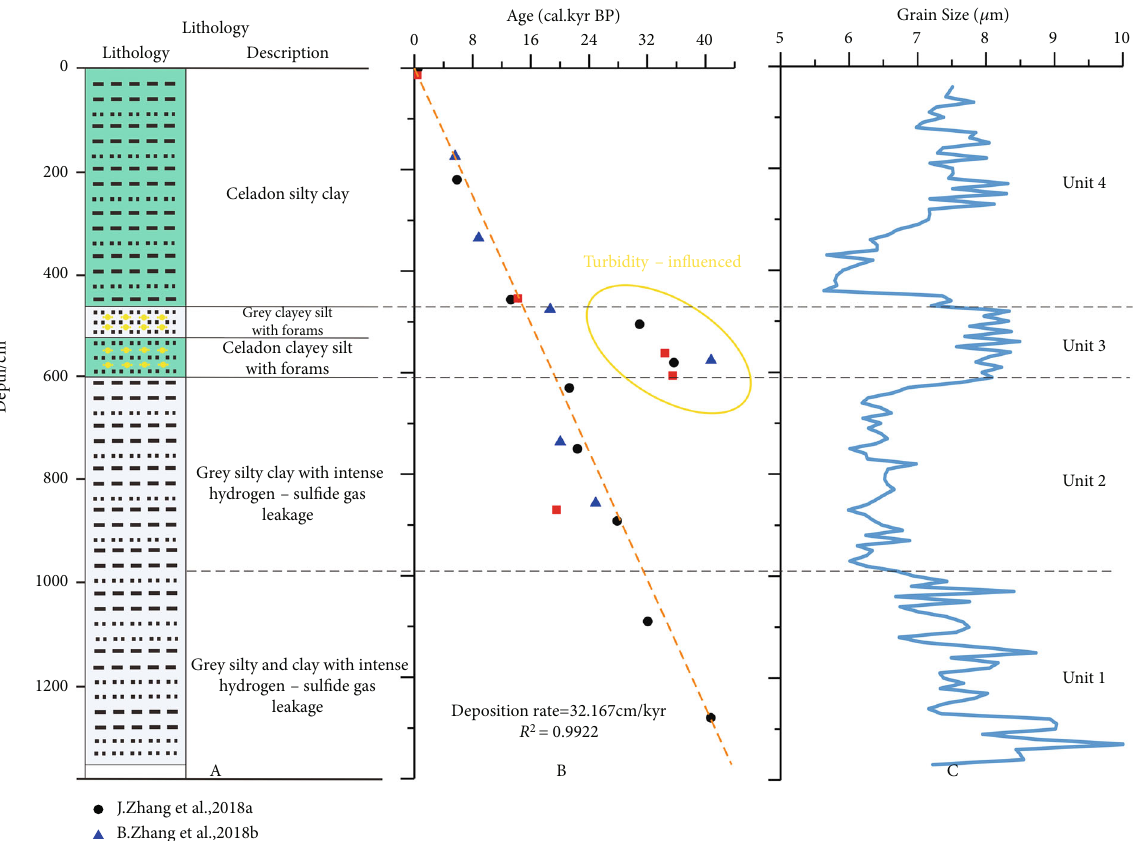
Figure 2: Downcore variations in lithology (a), calibrated age-depth model (b) and mean grain size (c). Lithological characteristics were summarized from [51]. The calibrated AMS 14 C dating was collected from [3, 19, 31, 52]. The yellow circle represents the abnormal intervals resulted from turbidity current, and the calibrated age presents great linear feature and high deposition rate (32.167 cm/kyr) except for several turbidite-in fl uenced data. Grain size data were taken from [31], and units 1-4 are de fi ned